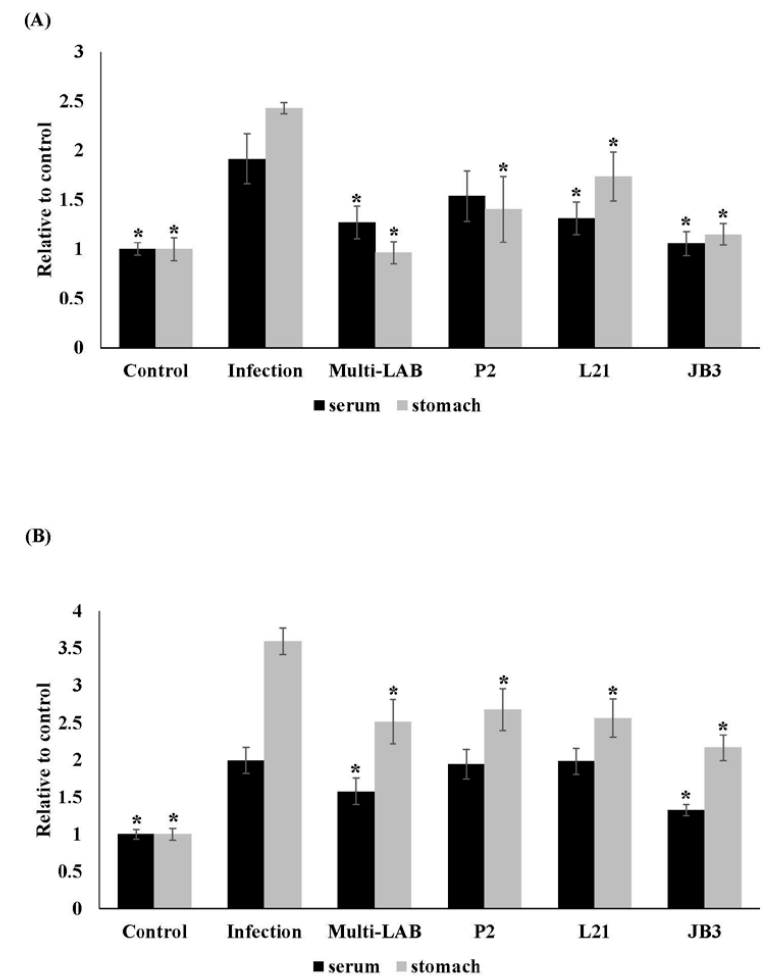
Figure 2. E ff ects of LAB strains on the H. pylori specific IgA ( A ) and IgM ( B ) levels in serum and stomach homogenates of mice. * Means significantly di ff erent from infection group, p <